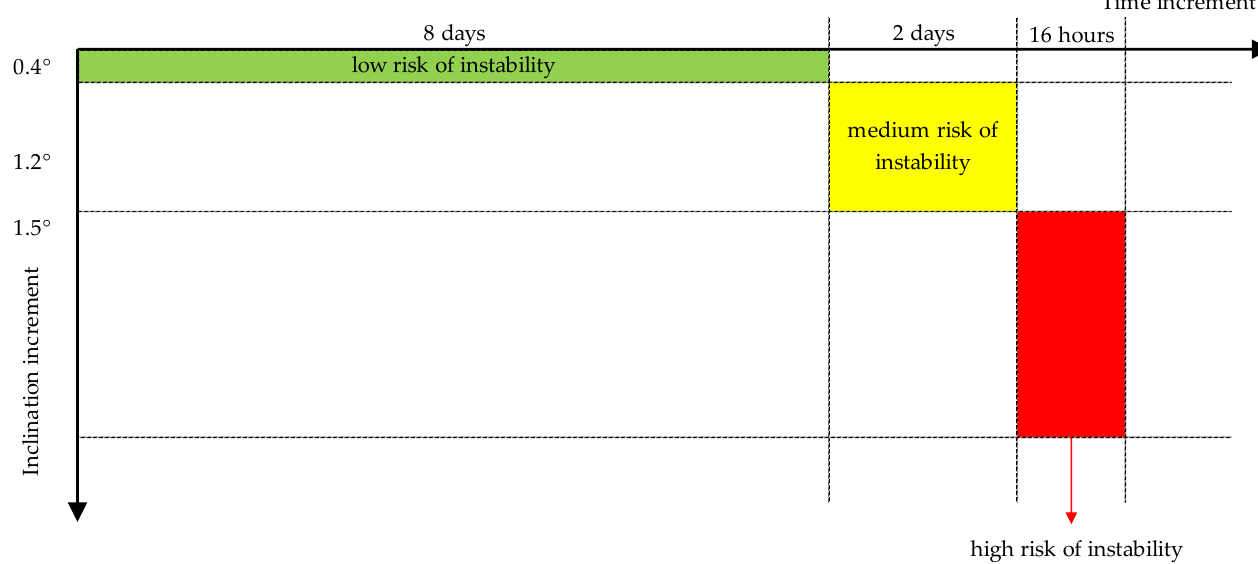
Figure 11. Graphic representation of the criterion to assess the stability of the roof layers.